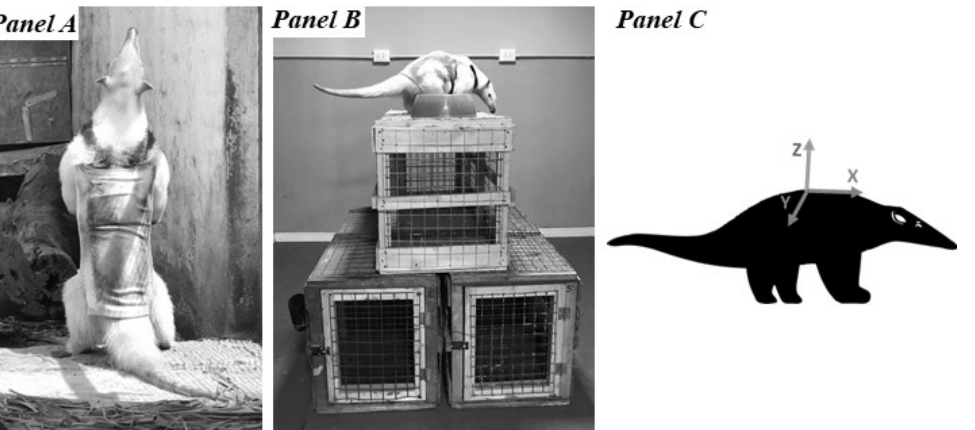
Figure 2. Photographs and illustration of adult lesser anteaters ( Tamandua tetradactyla ) at Biodiversity Park during Studies 1 and 2. Panel A: Male in the enclosure with the accelerometer-mounting accessory (vest). Panel B: Male on the climbing structure in the experimental room (Study 2). The two feeders, one in the lower left part and the other in the upper part, are shown. Arrows indicate the two feeders. Panel C: Diagram that represents the position of the X, Y and Z axes of the accelerometer in relation to the body of a lesser anteater. The vectorized image was specially designed to this study.